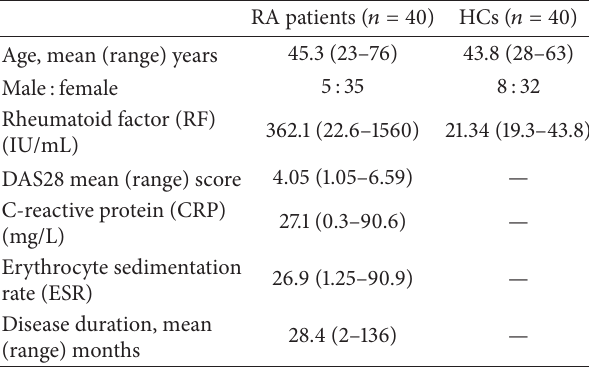
Table 1: Demographic and clinical characteristics of the patients with rheumatoid arthritis (RA) and healthy control (HC)